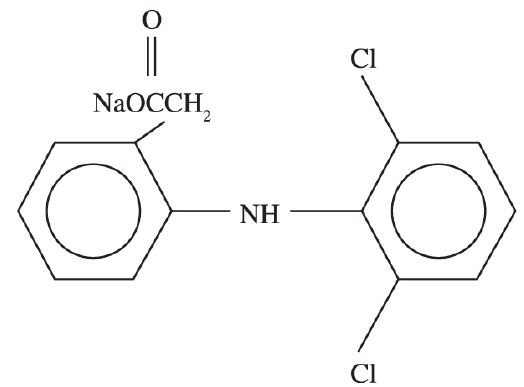
Figure 1. Molecular structure of sodium diclofenac 4